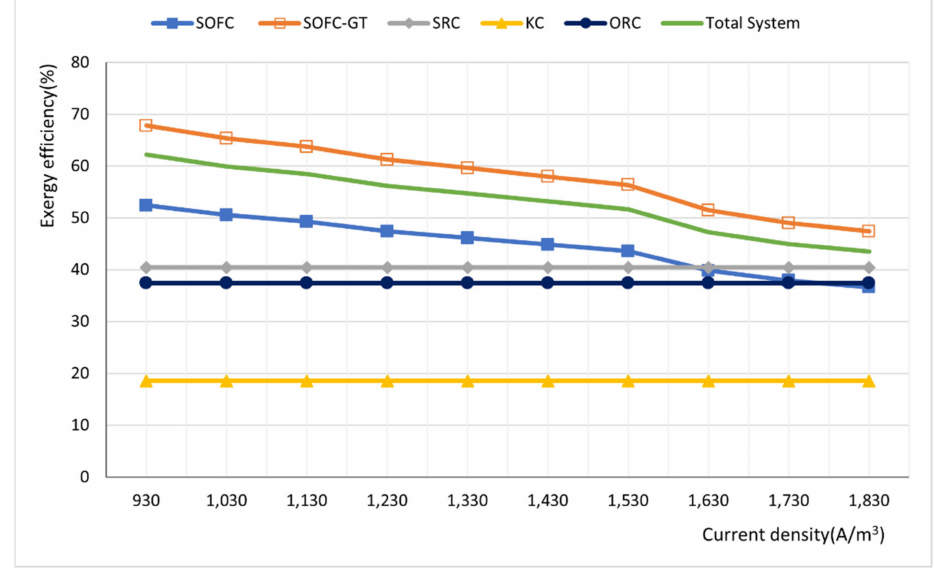
Figure 7. Effect of the current density on the exergy efficiency of